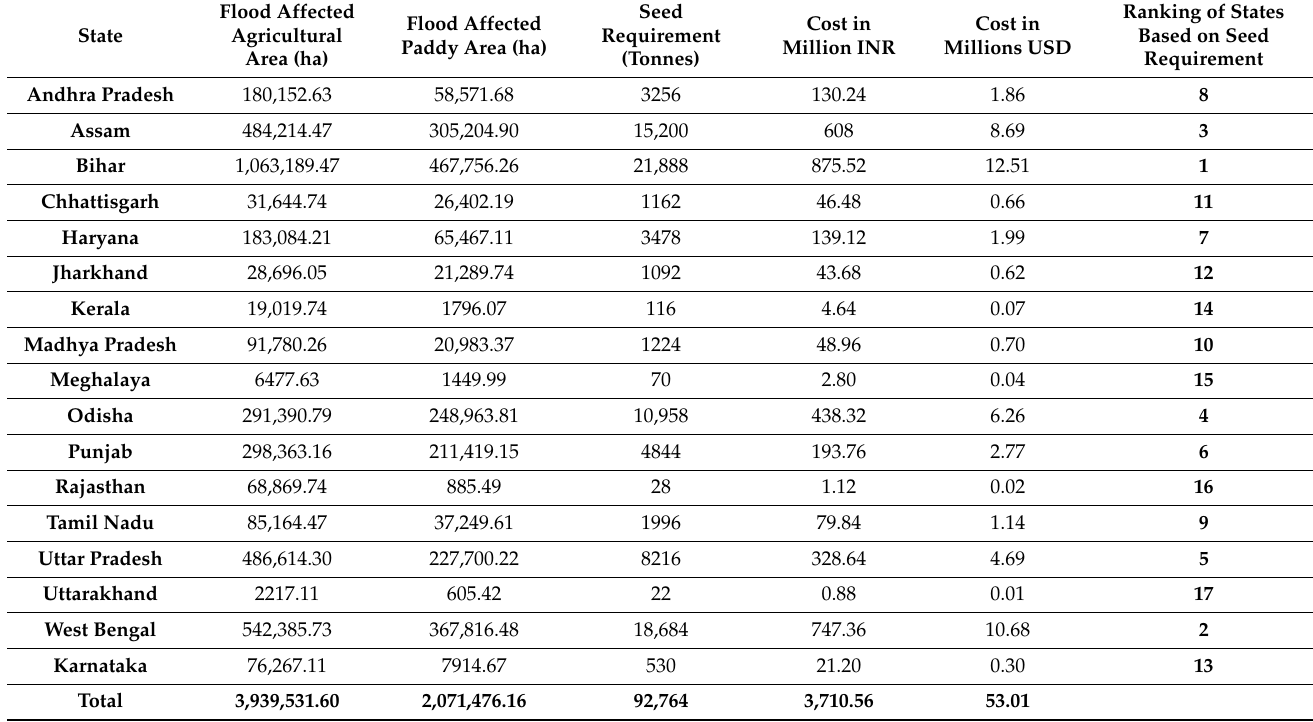
Table 2. State-wise total Swarna-Sub 1 seed requirement and cost of procuring in INR and USD.